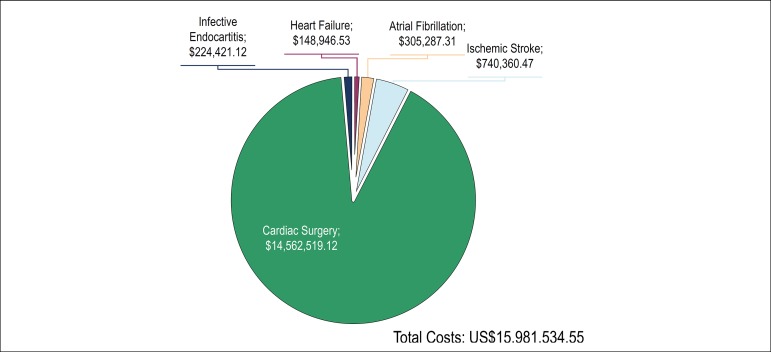
Projection of estimated minimum annual costs in US dollars for Rheumatic
Heart Disease morbidities. The final values were calculated based on the
case estimates made in Figure 2,
multiplying by the values detailed in Table 1, taking into account only one procedure or one
hospitalization for each patient over time.